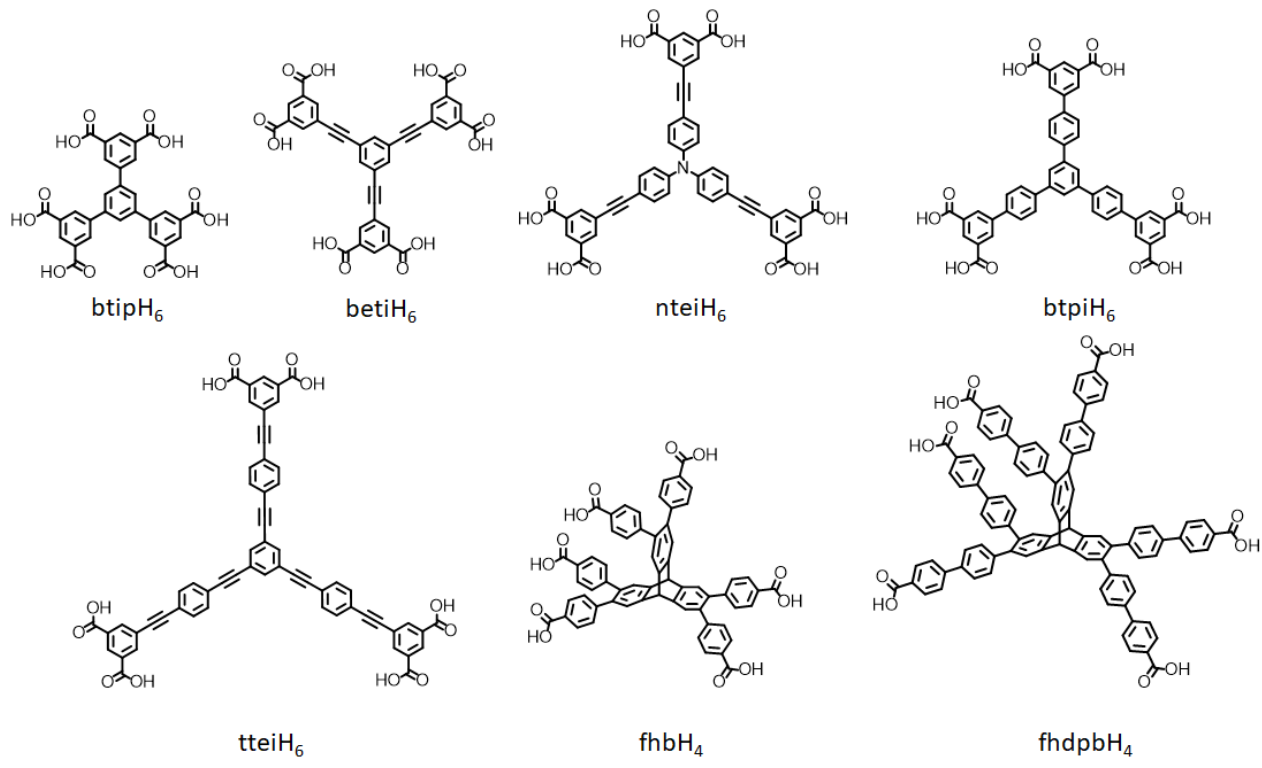
Scheme 2. Tritopic and tetratopic linkers used in the synthesis of HPMOFs.